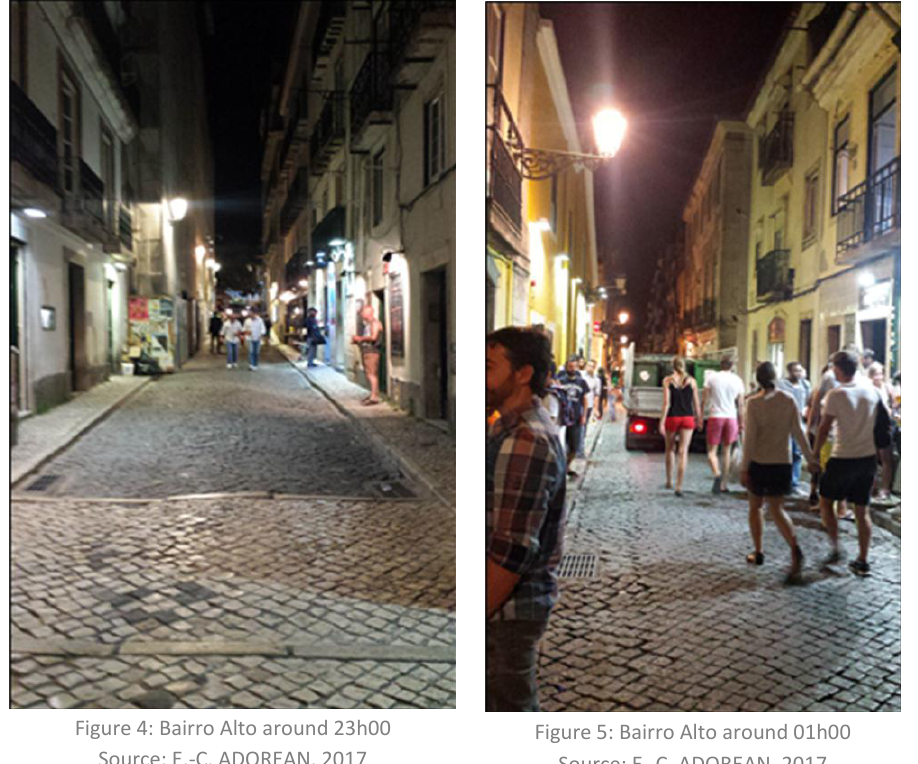
Figure 5: Bairro Alto around 01h00 Source: E.-C. ADOREAN,